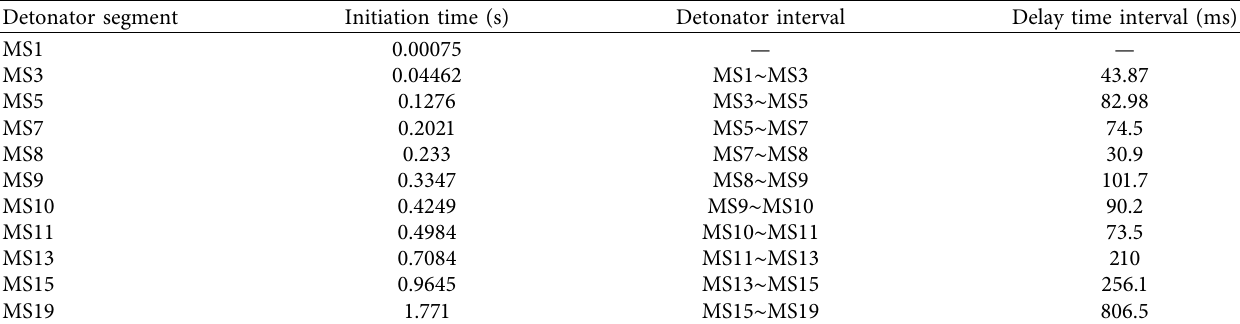
Table 2: Initiation time and time interval of each detonator.